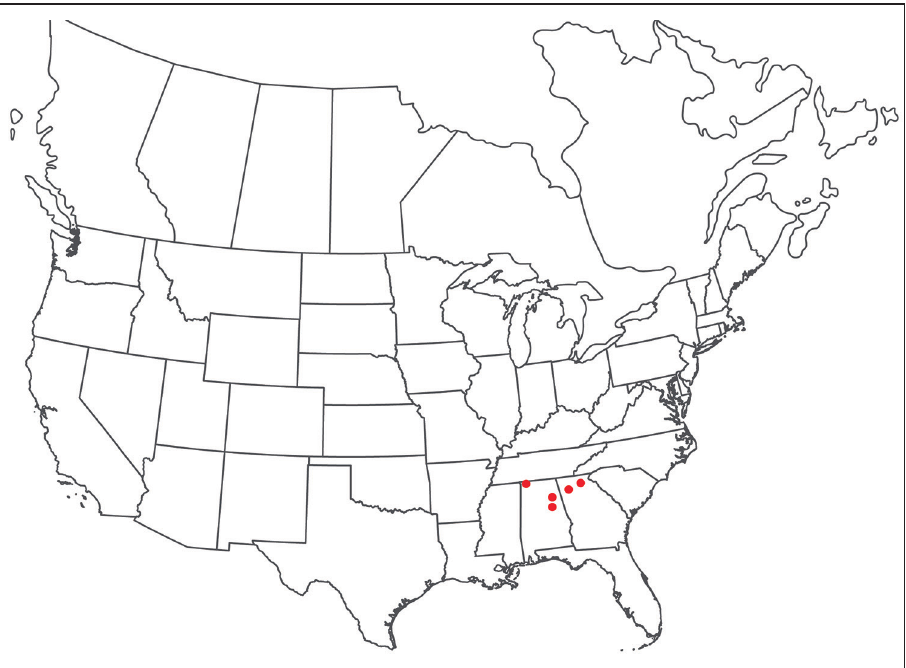
Figure 193. Torrenticola pollani sp. n.